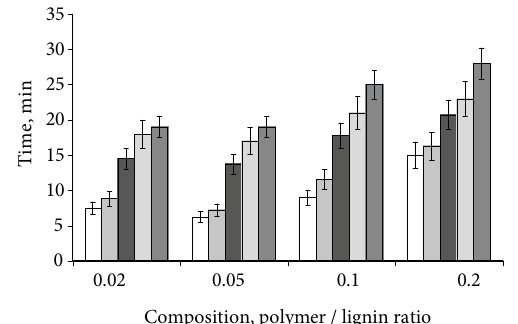
Fig. 4. Time of the onset of disintegration in cold water for composites made from